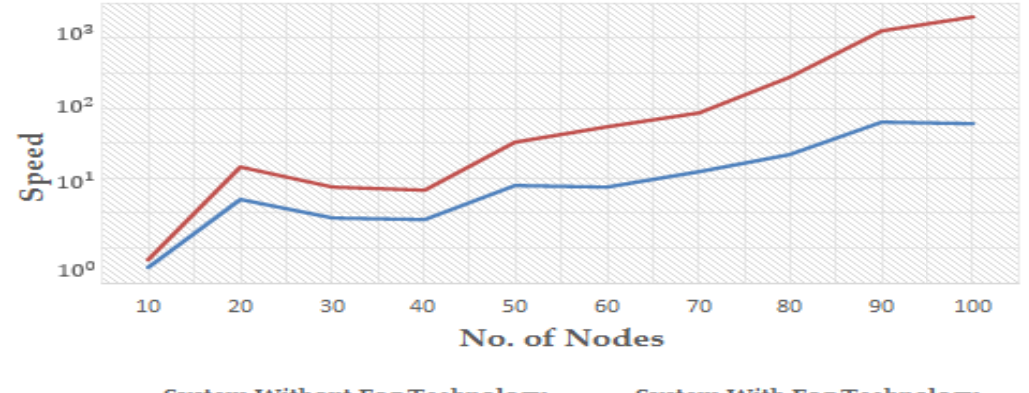
Figure 8. A comparison between system with fog and system without fog technology.